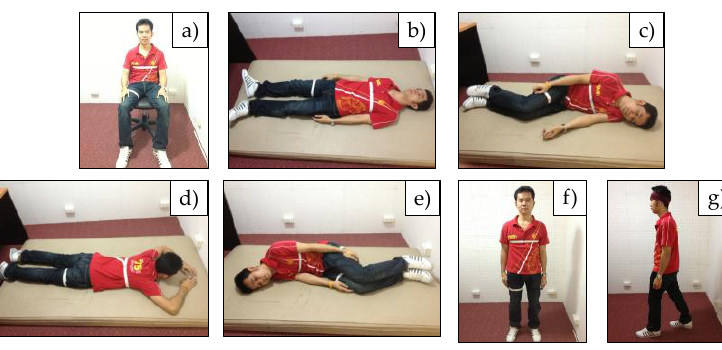
Figure 3. Sensor placements.